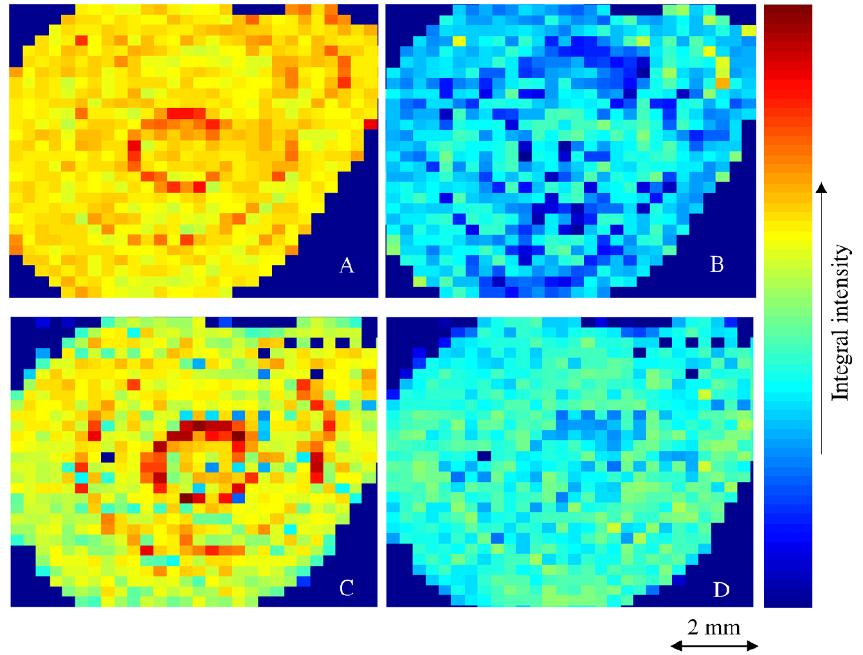
(C-C) at 1121 cm -1 ); C – FIR image of calcium s